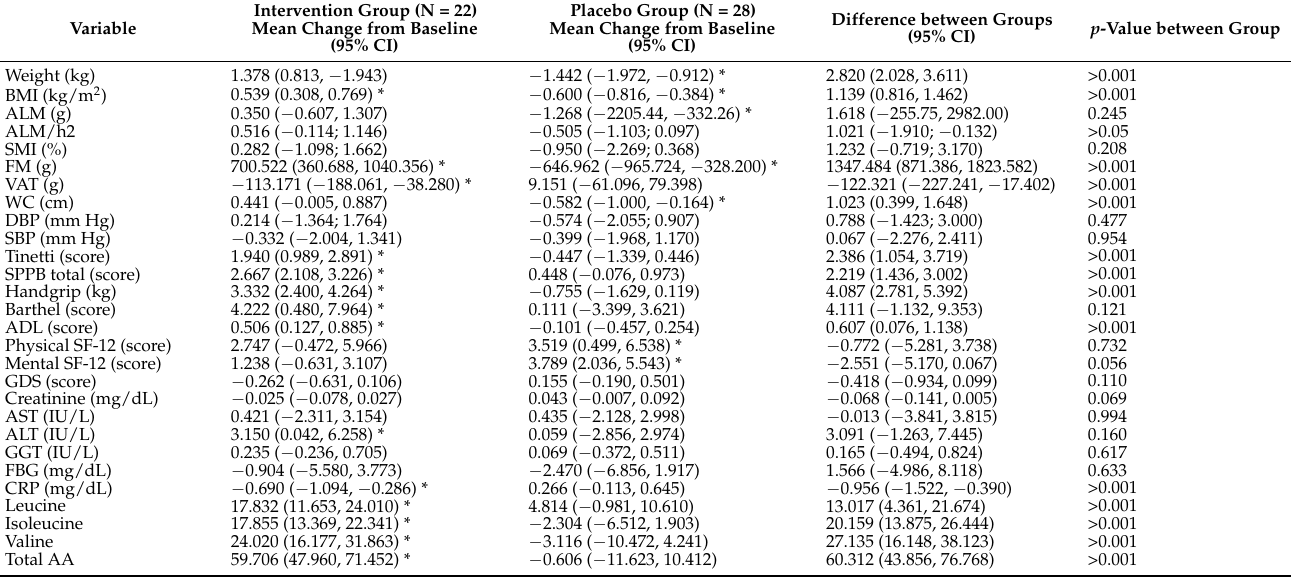
Table 2. Primary and secondary endpoints.